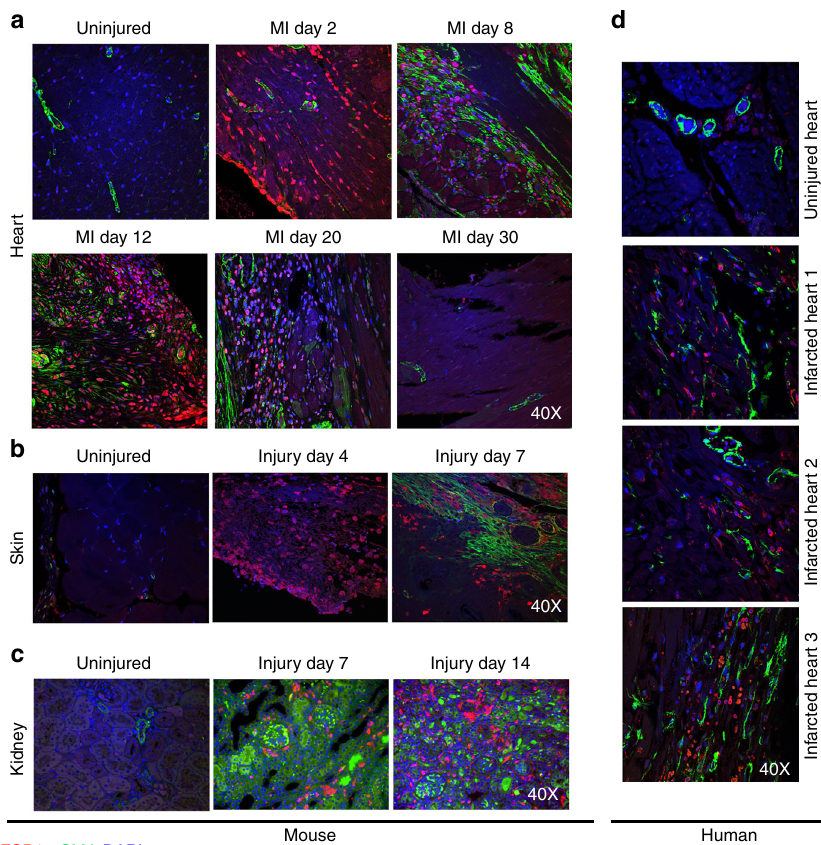
Fig. 1 FSP1 and α SMA mark distinct populations after multiple types of tissue injury. a Confocal analysis of FSP1 + and α SMA + cell populations from heart 2, 8, 12, 20, and 30 days post myocardial infarction (MI; ×40). Uninjured heart was used as control ( n = 3). b Confocal analysis of representative 1 µ